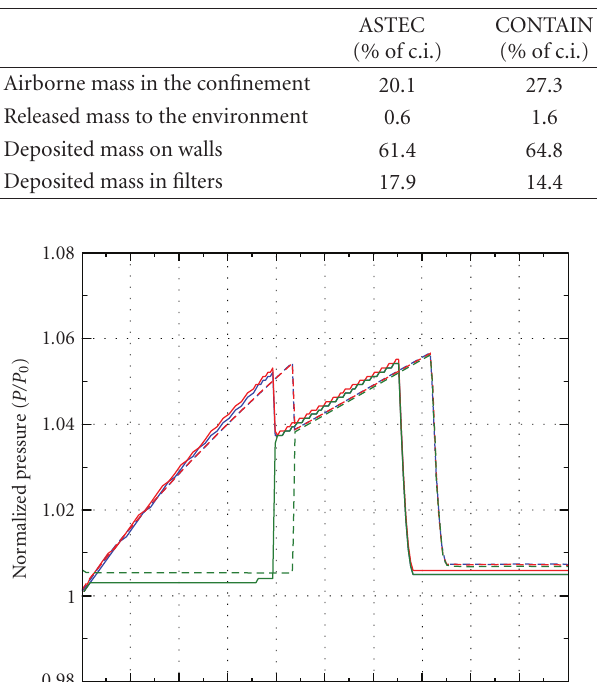
Table 1: Aerosol mass balance for the LB sequence.